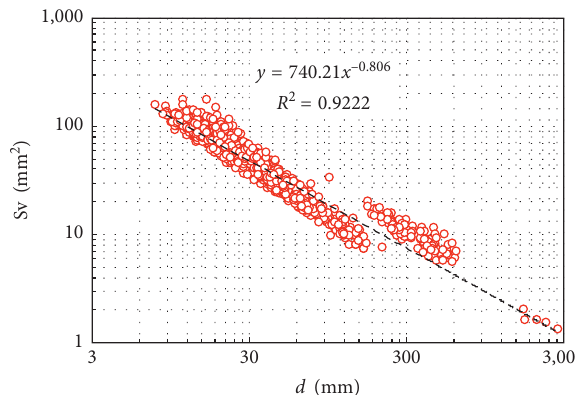
Figure 10: Relationship between specific surface area and particle size.